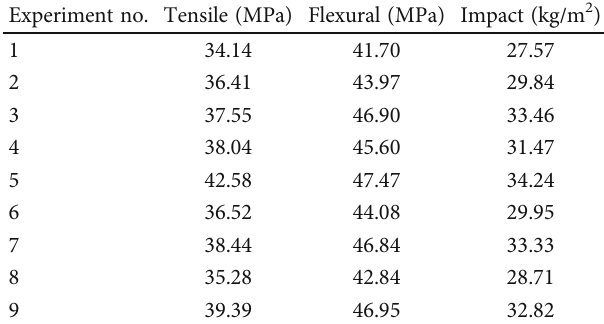
Table 3: Outcomes of current